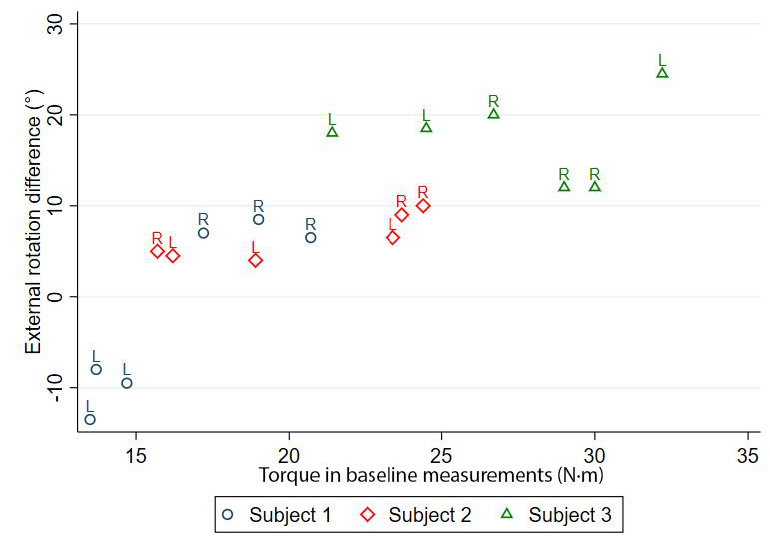
Figure 5. Differences in external rotation between baseline and post-LDTT (Test A) in cadaveric specimens for the maximum torque values. The values for each arm are shown separately for each of the three subjects (L = left; R = right). Three measurements per arm were recorded for both arms of the cadaveric specimens.